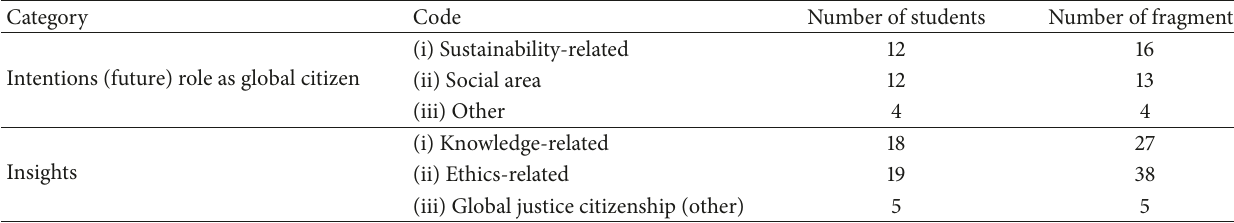
Table 9: Overview of codes assigned for each category SQ3, 𝑁 = 25